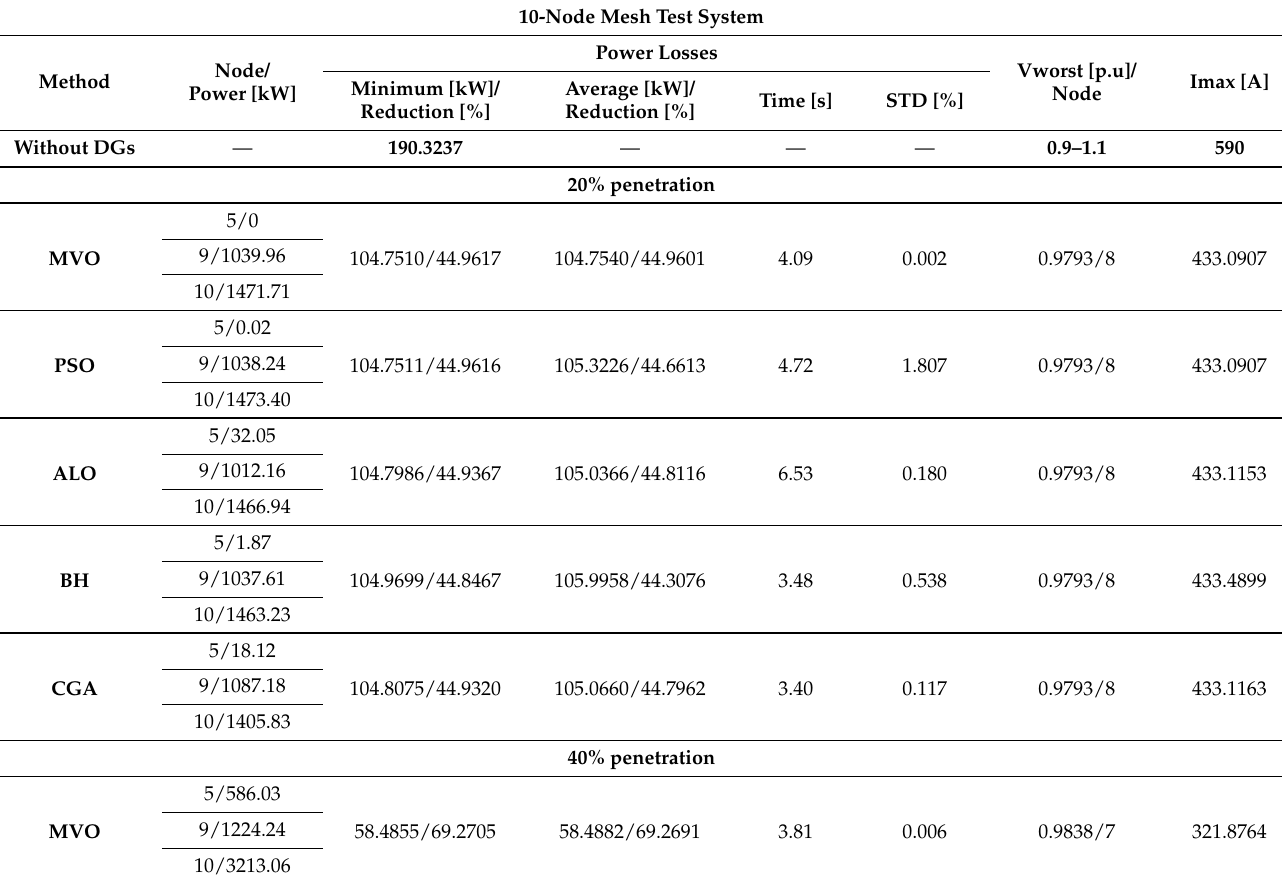
Table 10. Simulation results in the 10-node mesh test